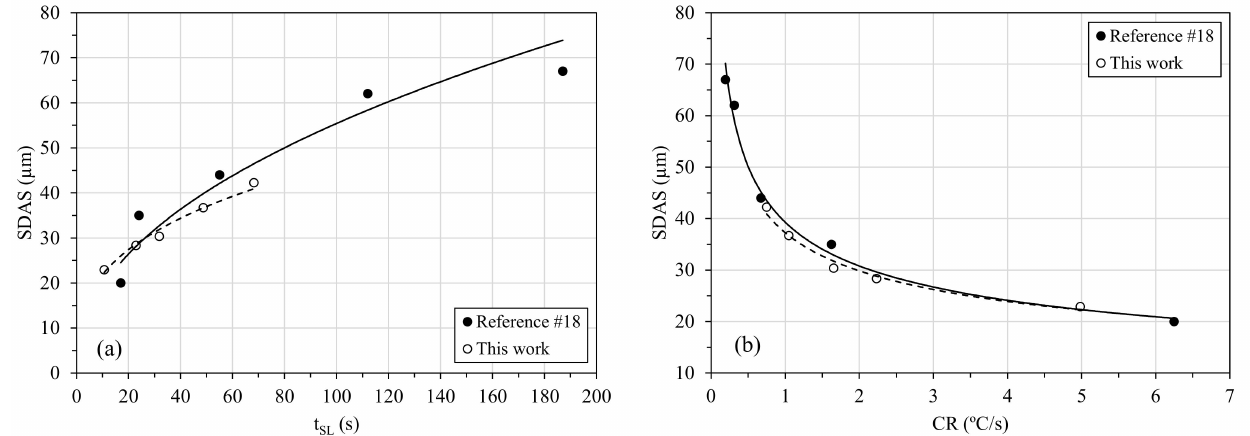
Figure 5. Evolution of experimental SDAS of the cylindrical test castings with ( a ) t SL and ( b ) CR. Black dots are obtained using data from